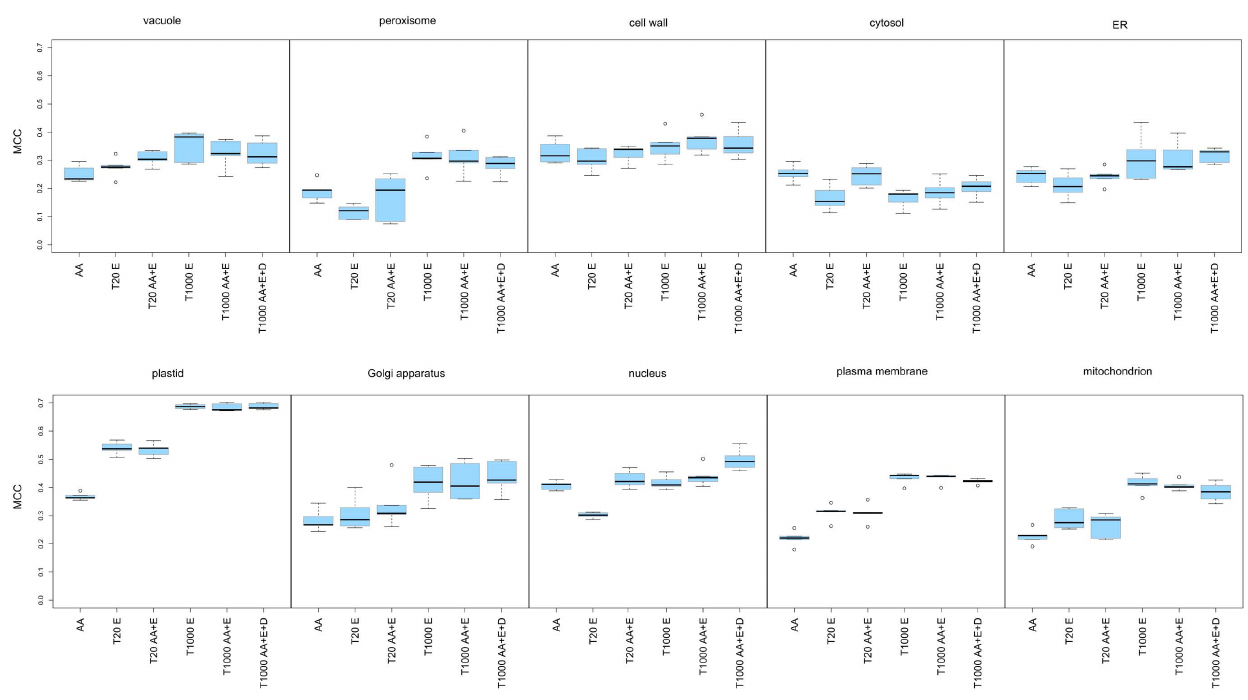
FIGURE 4 | Matthew’s correlation coefficient plots presenting the performance of the predictors constructed for 10 subcellular compartments. The investigated compartments were: the vacuole, the peroxisome, the cell wall, the cytosol, the ER, the plastid, the Golgi apparatus, the nucleus, the plasma membrane, the mitochondrion. For each of the 10 compartments the prediction engines were built using: amino acid composition (AA), the top 20 expression features (T20 E), the top 20 mixed